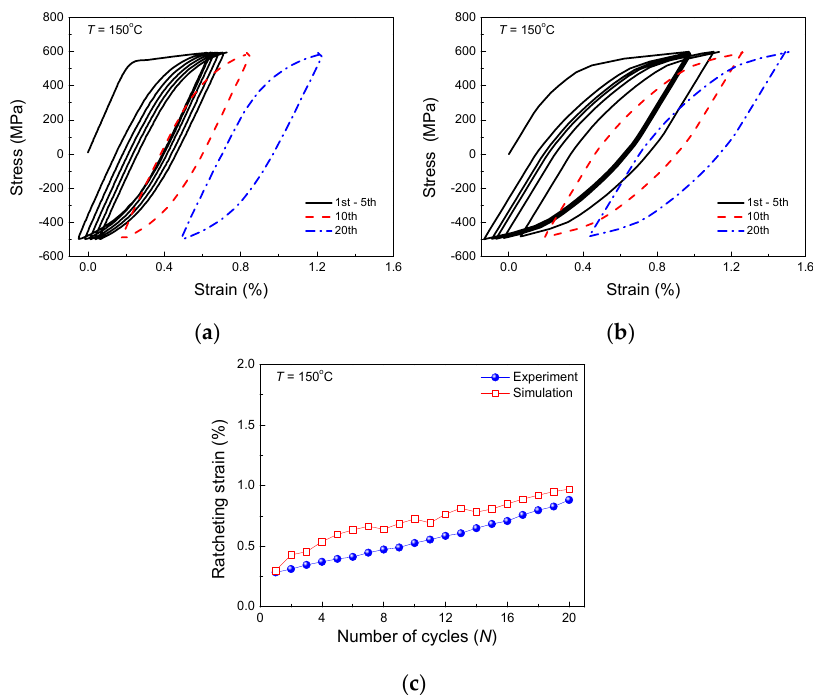
Figure 8. Results of the notched bar at 150 °C: ( a ) experimental stress-strain curves, ( b ) simulated stress-strain curves and ( c ) experimental and simulated ratcheting strains versus number of cycles.